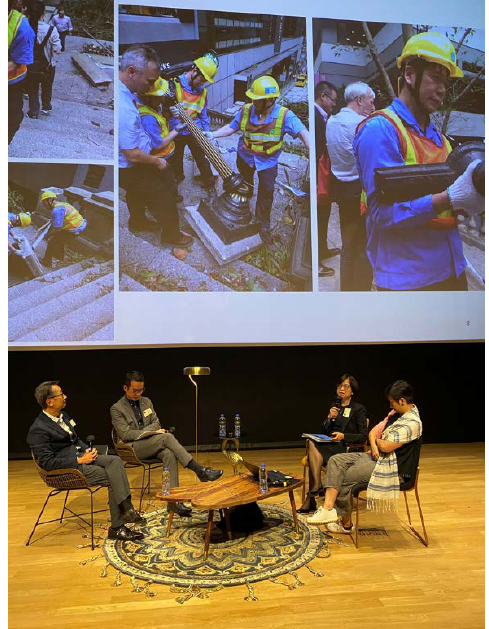
Figure 16: The project teams shared the restoration experience in a public